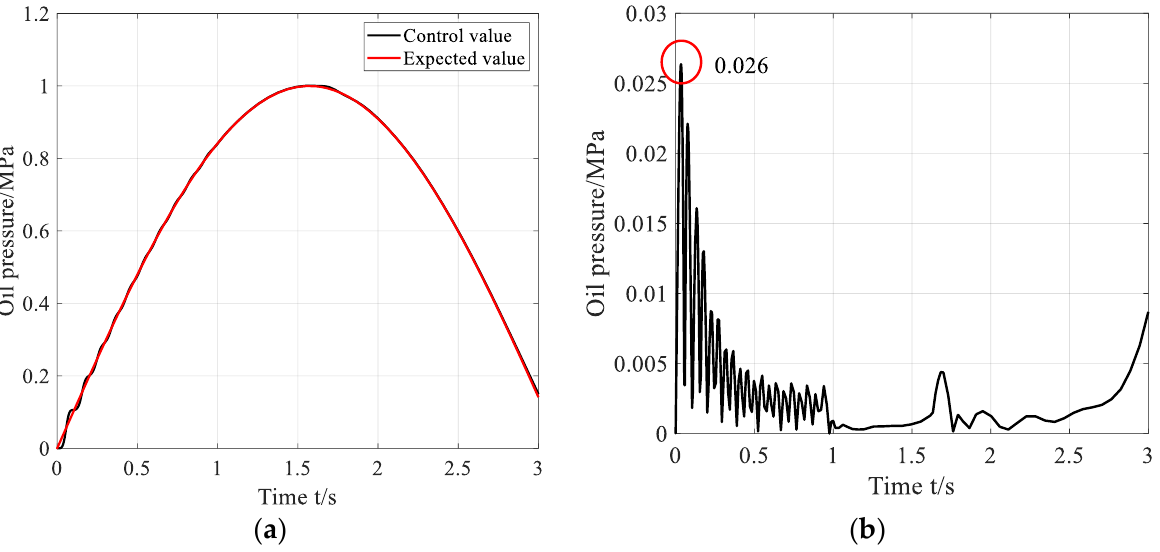
Figure 7. Sine wave signal following control of oil pressure controller based on backstepping algorithm. ( a ) Target oil pressure; ( b ) following error.